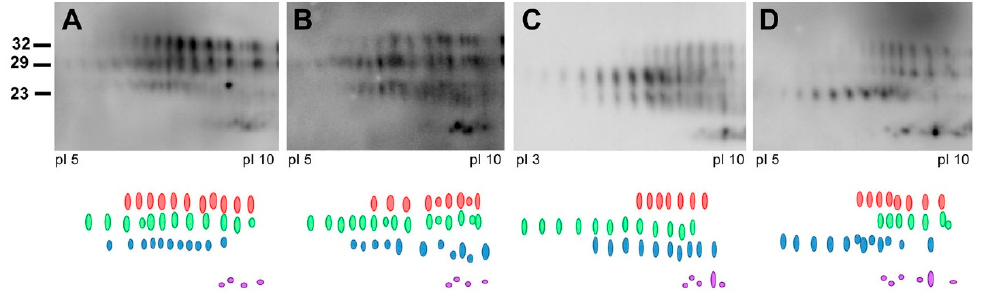
Figure 2. Representative images of PrP Sc 2D-electrophoresis are shown. PrP Sc was precipitated from brain homogenate using sarkosyl and NaPTA. Extracted proteins were separated in the first dimension on Ready-Strip IPC strips (Bio-Rad) and a pH gradient of 3–10. Following equilibration in SDS and reducing/alkylating agents, the second dimension of the gel was performed on Criterion Tris-HCL polyacrylamide precast gels (8–16%) prior to Western blotting. PrP Sc was detected using the 3F4 antibody and an HRP secondary. Four strips of spots were identified at different molecular weights: 32 kDa (red), 29 kDa (green), 23k Da (blue) and 13/14 kDa (purple). ( A ) Non-venison exposed CJD subject; ( B – D ) venison exposed CJD subjects.